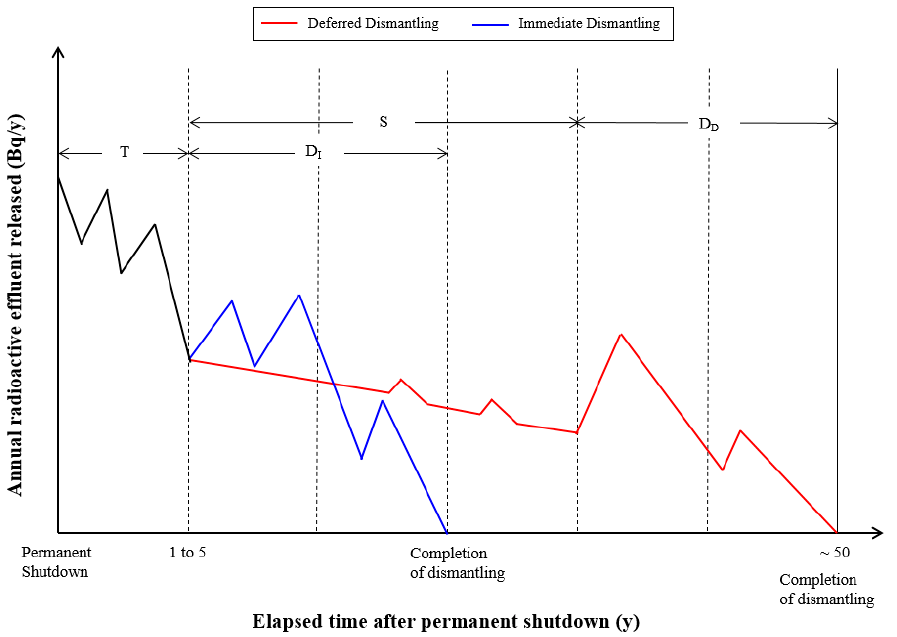
Figure 2. Generalized profile of radioactive effluent discharges after PS of NPPs taking into account decommissioning activities and immediate/deferred dismantling strategies. Each peak represents increment of radioactive discharges to be induced by decommissioning activities including but not limited to shipping out SF, drainage of primary coolant and SFP water, dismantling and decontamination of SSCs using wet/dry processes. T represents transitional period after PS, and D I , D D , and S stand for respective decommissioning periods.